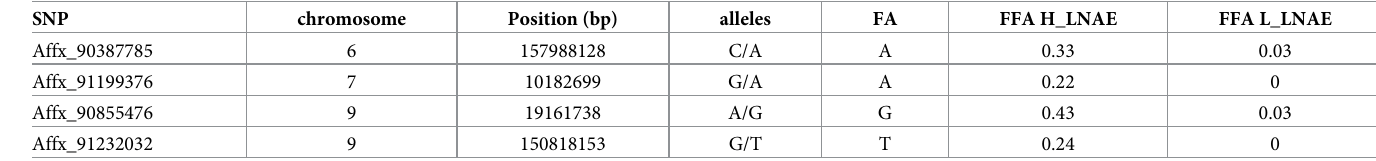
Table 2. SNPs under directional selection between H_LNAE and L_LNAE groups identified using BAYESCAN software. FA = favorable allele; FFA H_LNAE = frequency of the favorable alleles in the H_LNAE group; FFA L_LNAE = frequency of the favorable allele in the L_LNAE group. SNP